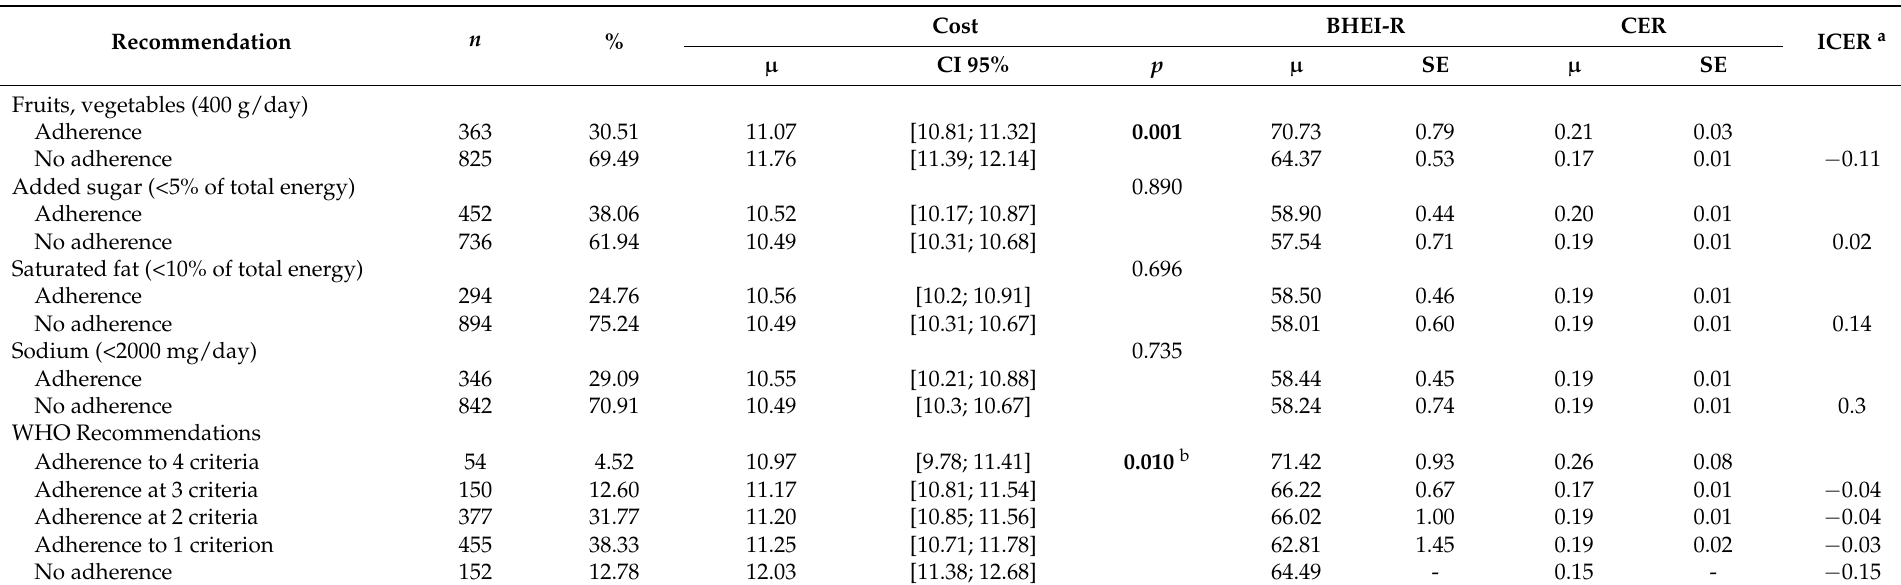
Table 3. Cost-effectiveness ratio, diet cost, and quality, according to WHO recommendations. ISA-2015, Sao Paulo,